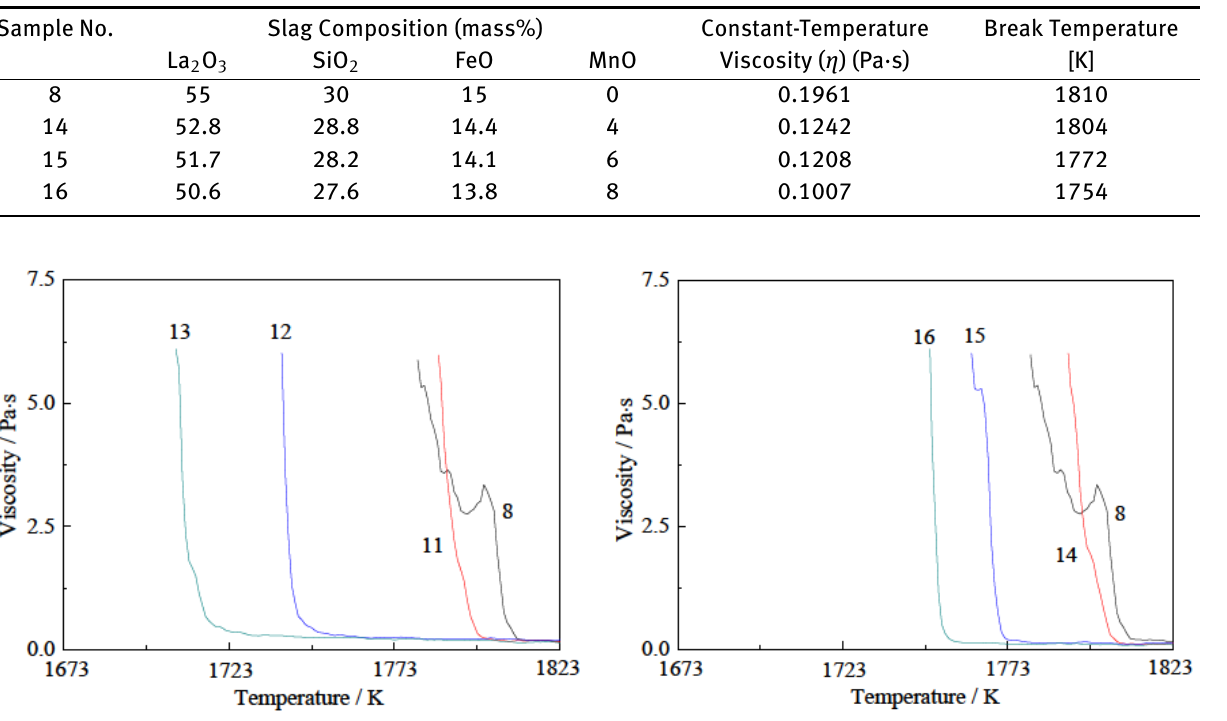
Figure 3: Viscosity curves of La 2 O 3 -SiO 2 -FeO-Al 2 O 3 slags. Figure 4: Viscosity curves of La 2 O 3 -SiO 2 -FeO-MnO slags.